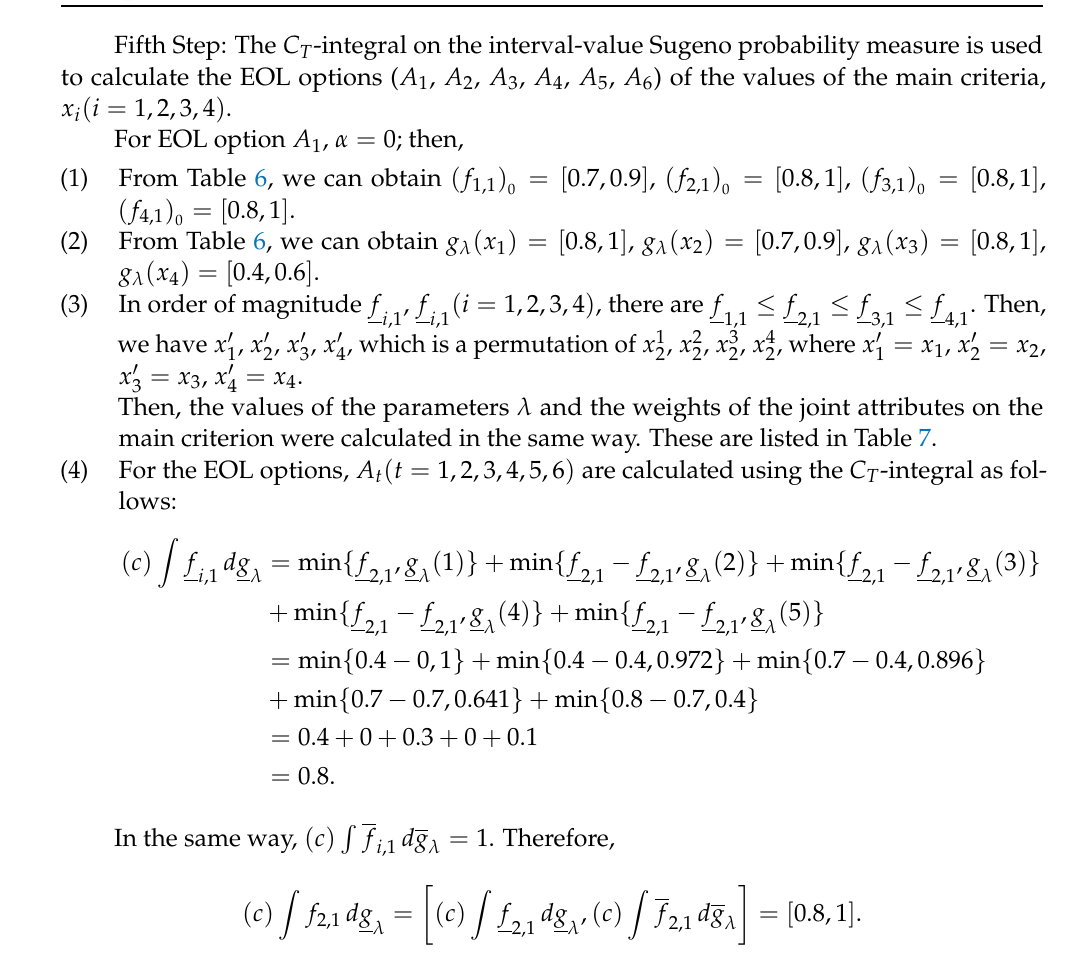
Fifth Step: The C T -integral on the interval-value Sugeno probability measure is used to calculate the EOL options ( A 1 , A 2 , A 3 , A 4 , A 5 , A 6 ) of the values of the main criteria, x i ( i = 1, 2, 3, 4 )